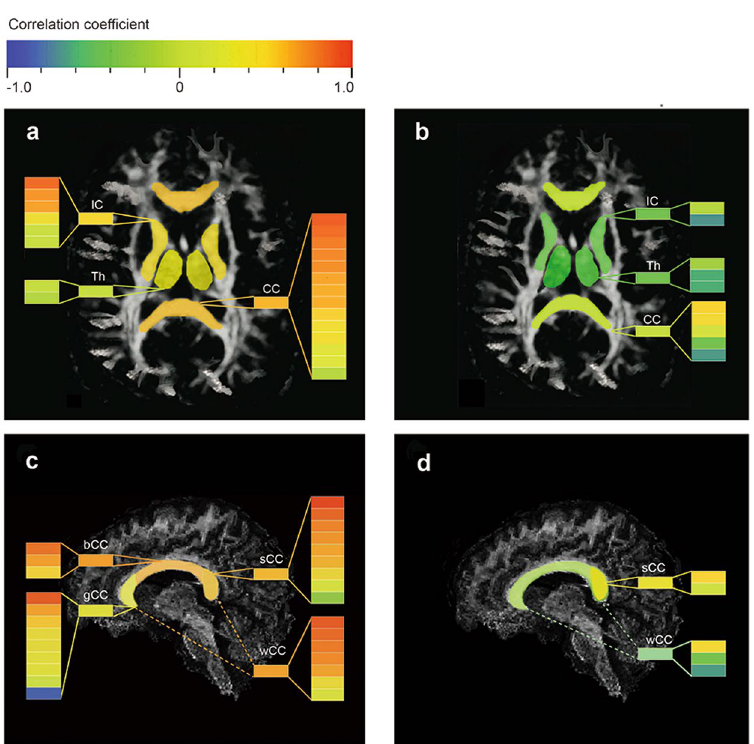
Figure 5. Colour-bar maps to visualize correlation coefficients in regions of interest. Positive correlations are shown in hot colours while negative correlations in cool colours. Each colour bar within a column represents a single study, and the colour bar before the column reflects pooled data after meta-analysis. ( a ) Colour-bar map reflecting FA-consciousness correlations in several brain regions. ( b ) Colour-bar map reflecting ADC- consciousness correlations in several brain regions. ( c ) Colour-bar map reflecting FA-consciousness correlations in subareas of the CC. ( d ) Colour-bar map reflecting ADC-consciousness correlations in subareas of the CC. CC, corpus callosum; IC, internal capsule; Th, thalamus; CS, centrum semiovale; sCC, splenium of corpus callosum; bCC, body of corpus callosum; gCC, genu of corpus callosum; wCC, whole corpus